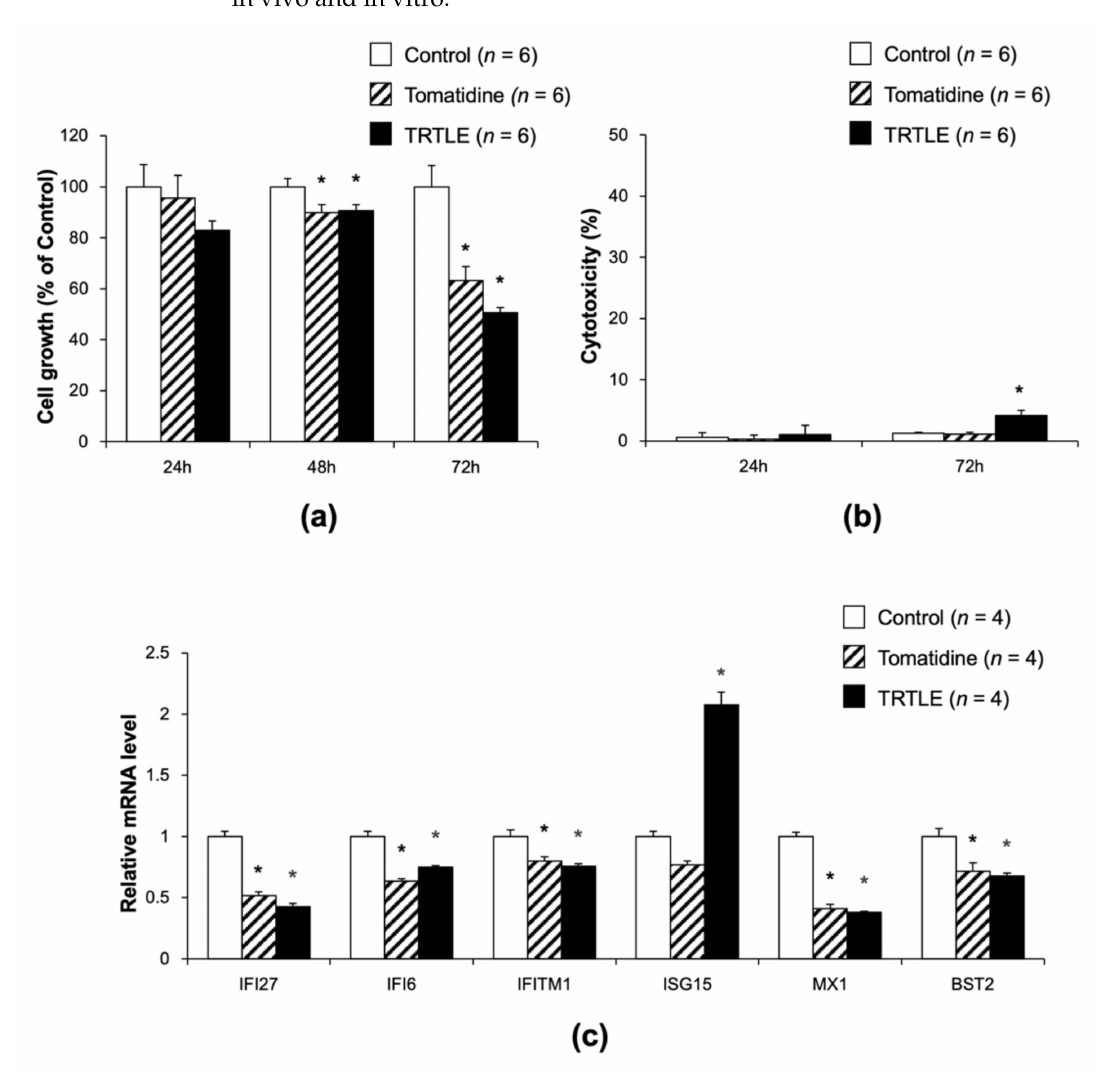
Figure 4. Effects of tomatidine and TRTLE on the proliferation of 85As2 gastric cancer cells. After incubation of 85As2 cells for 24 h, 48 h or 72 h without (Control) or with tomatidine (Tomatidine) or TRTLE, their ( a ) cell growth and ( b ) cytotoxicity were measured. ( c ) mRNA levels of type I interferon- stimulated genes (ISGs) were measured in the 85As2 cells treated with tomatidine or TRTLE for 72 h. n = 4–6, means ± SE. * p < 0.05 vs.